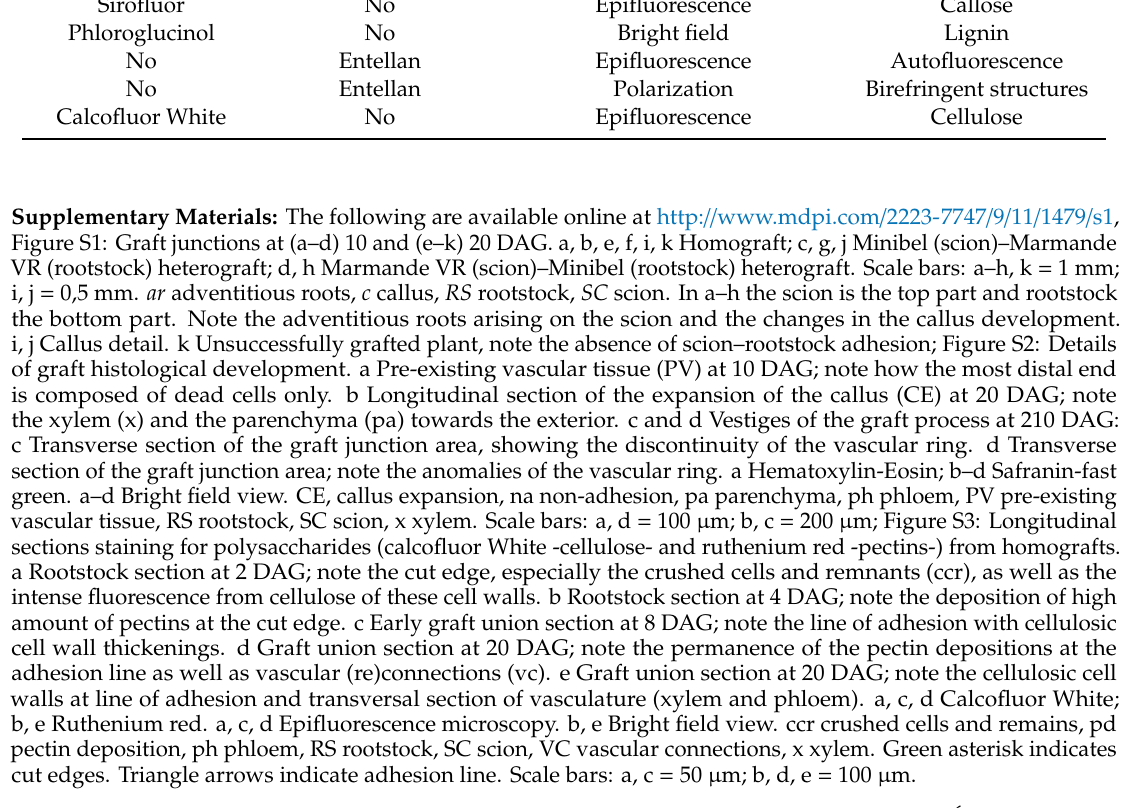
Table 2. Preparation of slides and microscope observations.